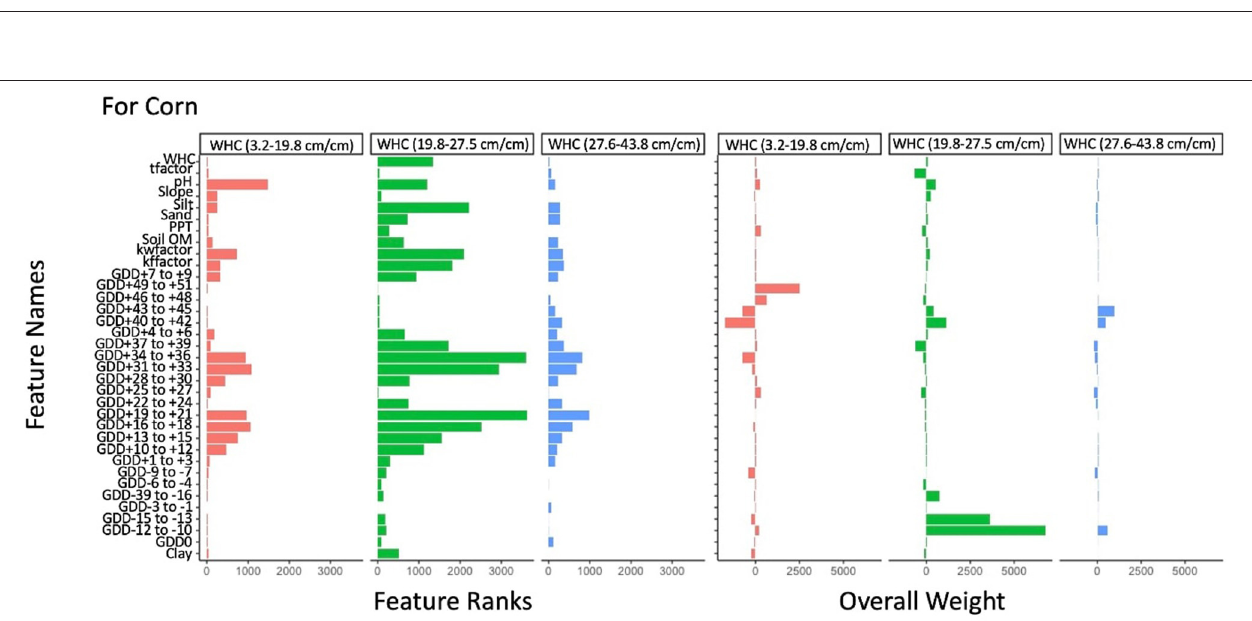
FIGURE 10 | Feature ranks and overall weight of features following explainable machine learning interpretations for corn for low, medium, and high quartiles of water holding capacity.